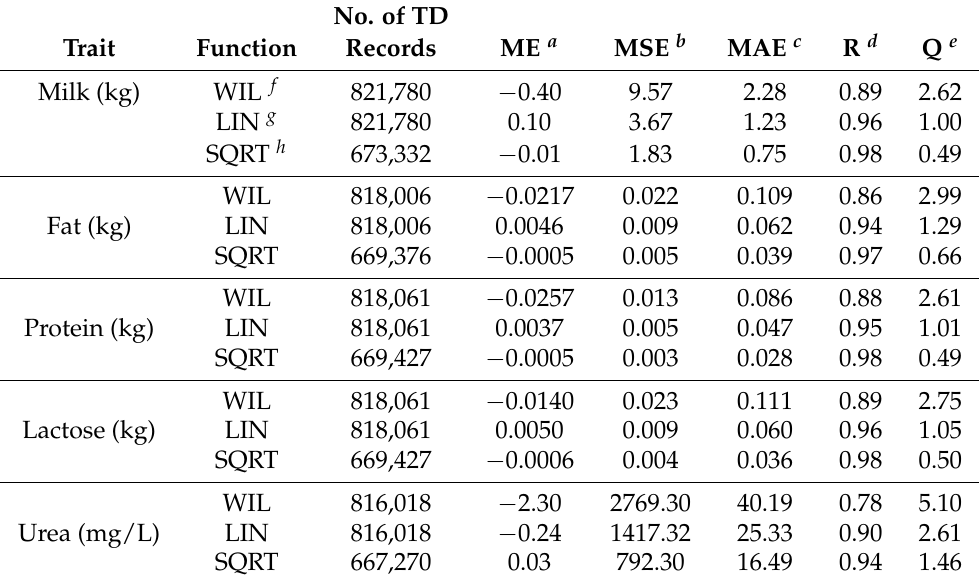
Table 5. Goodness of fit of different functions to test-day (TD) records beyond 305 day in milk. No. of TD